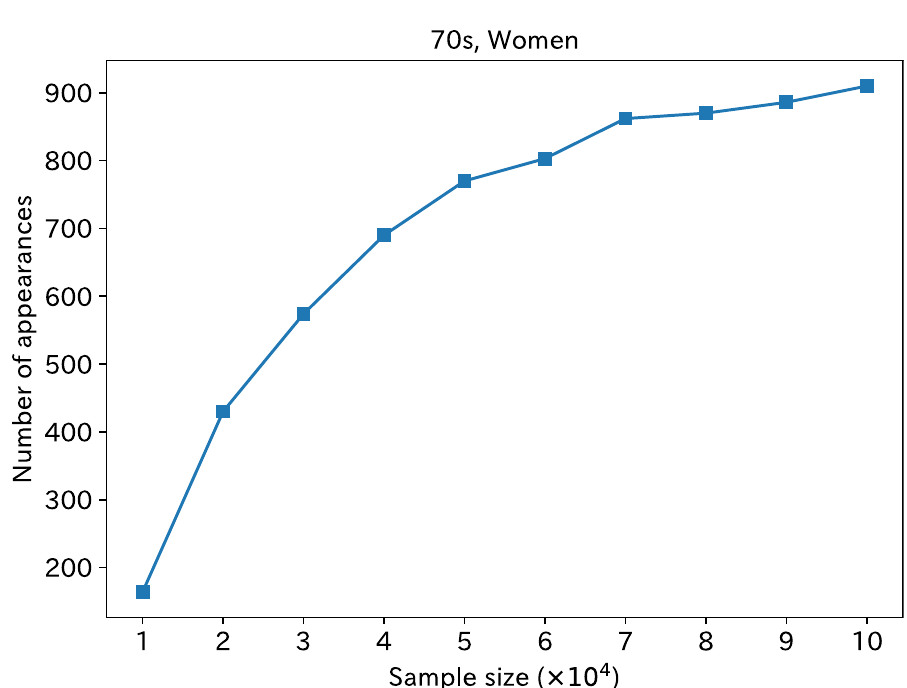
Fig 6. Number of cases in the top ordering, shown as a function of the sample size. The number of cases is expressed as the frequency on the vertical axis with the full amount of 1000.